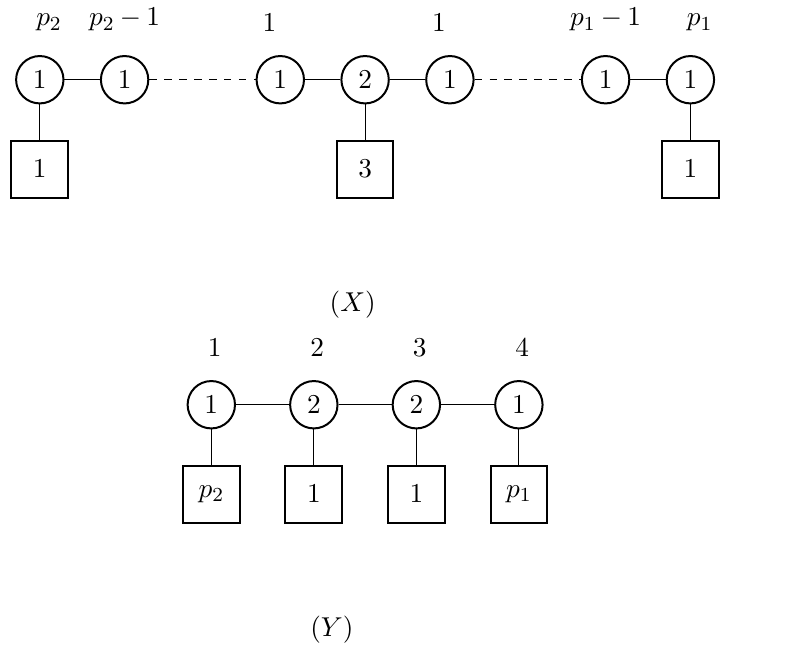
Figure 24 . Pair of linear quivers with U(1) gauge groups which generate the 3d mirrors in figure 23.